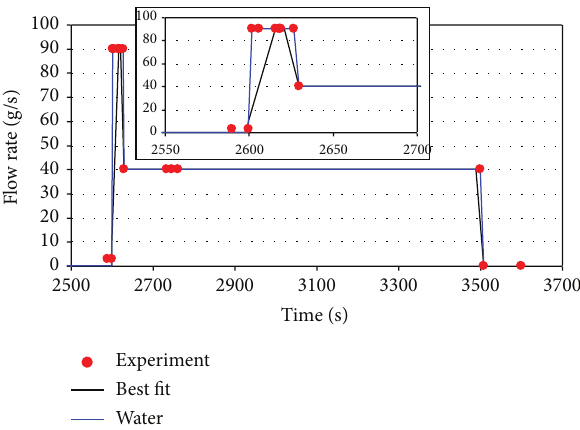
Figure 6: Flow rate of quenching water in different calculation sets.